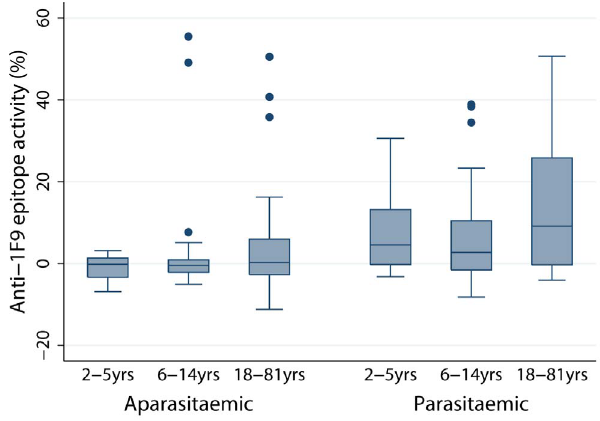
Figure 2. Levels of inhibition of 1F9-binding by human antibodies according to age group and infection status in the Ngerenya cohort. Values show the level of inhibition of 1F9 mAb binding to AMA1 by human serum antibodies, stratified by infection status at the time of sample collection and grouped according to age. Boxes indicate median and interquartile range, and whiskers represent 95% CI. Positive 1F9 inhibition was defined as inhibition of 1F9 binding . (mean + 2 standard deviations of negative controls=6.19%). Differences in the level of anti-1F9 activity among age groups was significant amongst aparasitemic individuals (P=0.020, Kruskal Wallis test), but not amongst parasitemic individuals. The median level of anti- 1F9 activity was lower amongst aparasitemic compared to